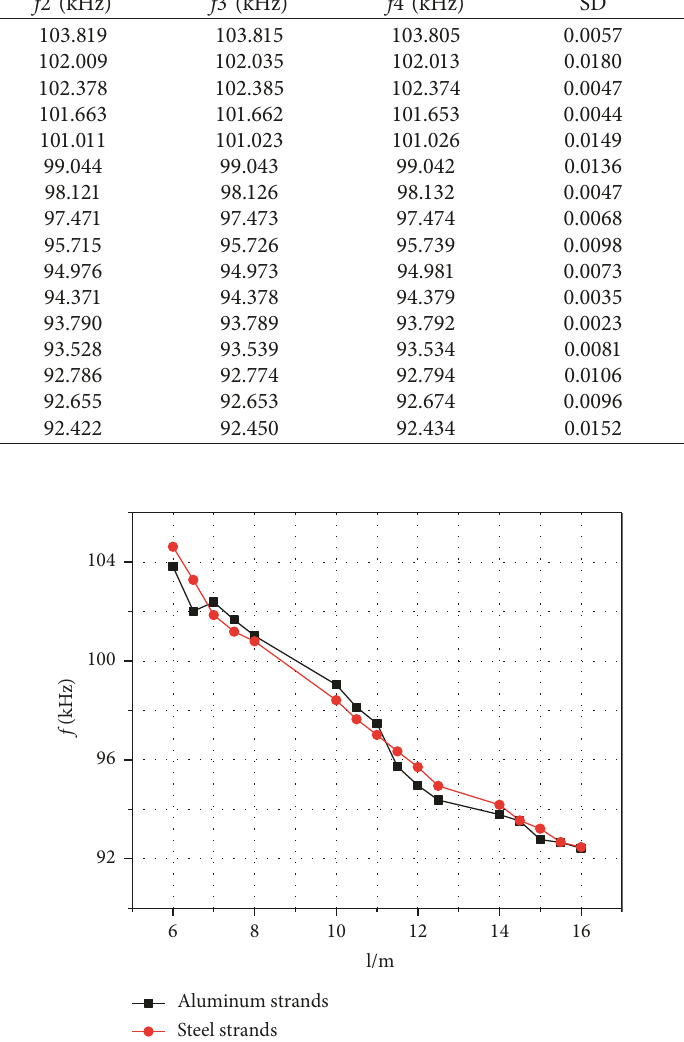
Figure 10: l- f analysis diagram of steel strands/aluminum